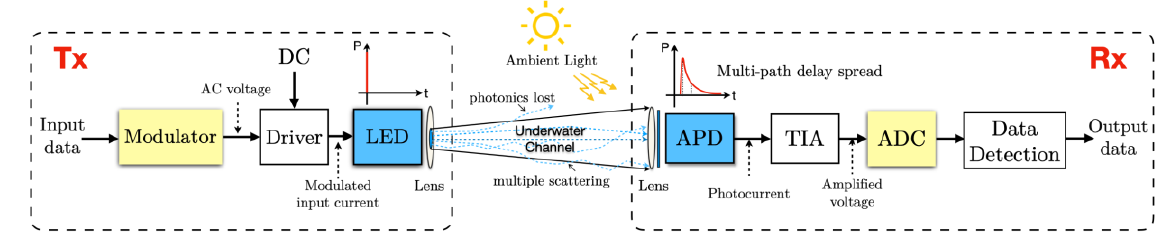
Figure 2. Schematic Diagram of the UOWC system model.